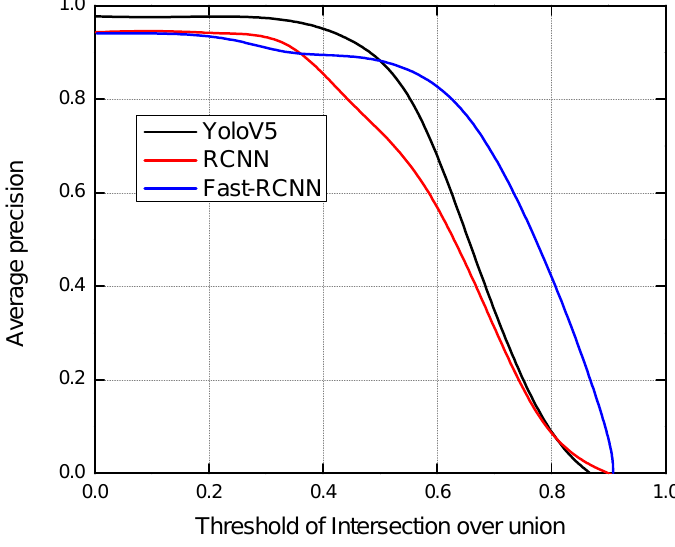
Figure 10. Average precision vs. Threshold of Intersection over union for our CNN